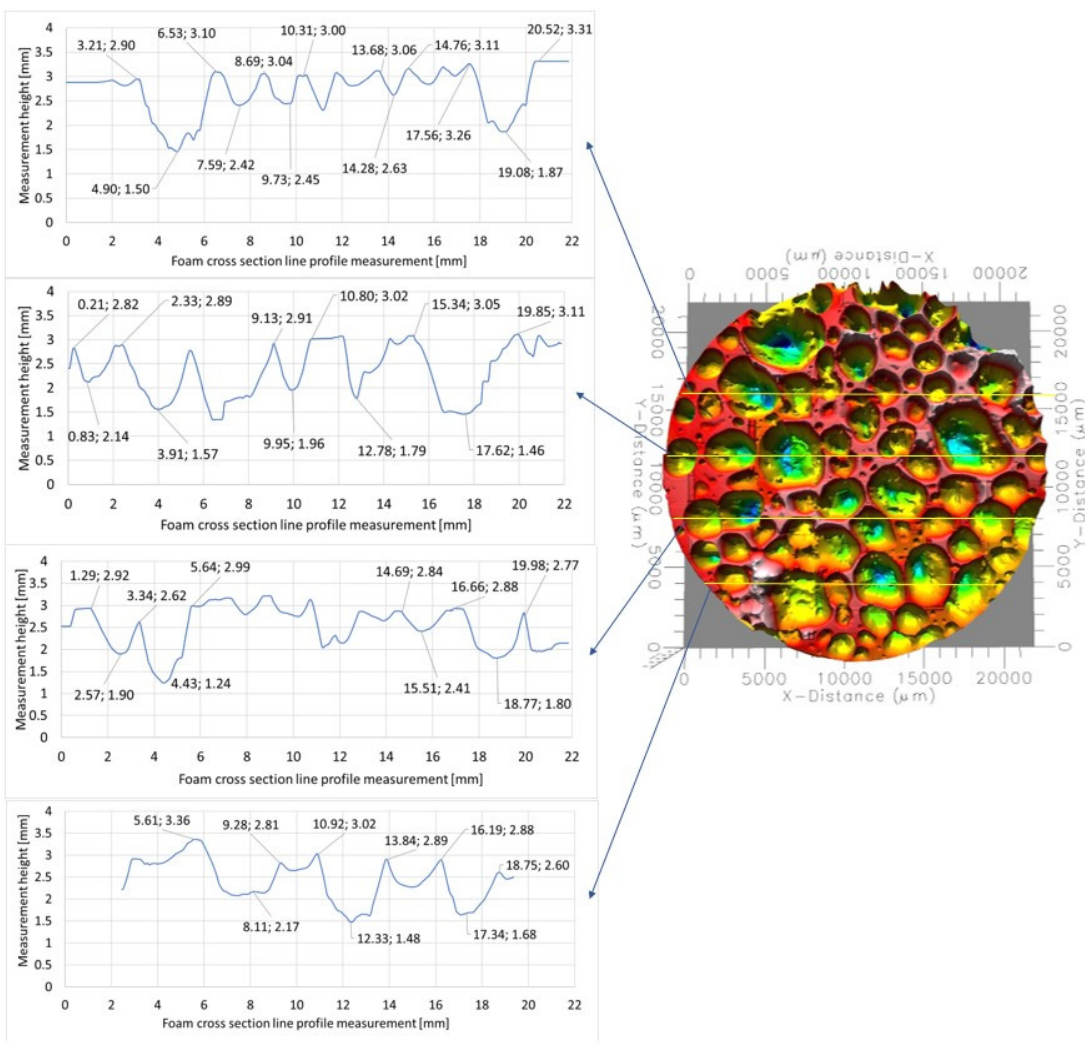
Figure 3. Three-dimensional surface of metal foam with a density of 0.65 g/cm 3 and selected cross-section profile line measurements.